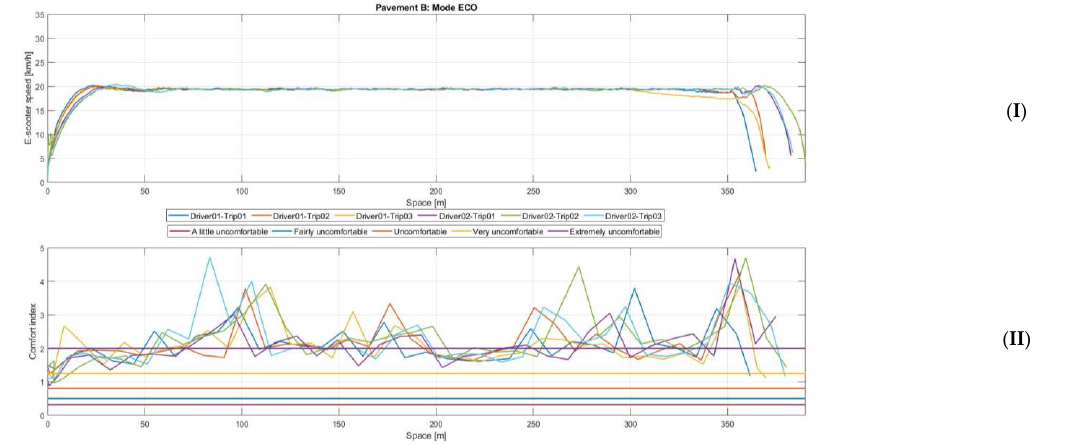
Figure 9. Speed profile ( I ) and comfort index ( II ) for 2 s RMS, pavement B, and mode ECO.